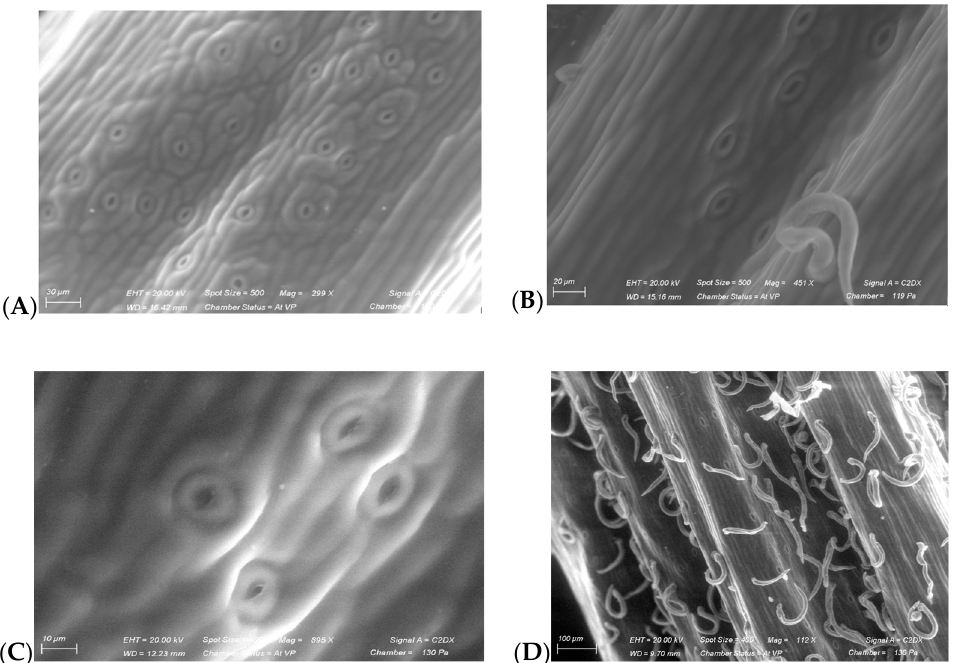
Figure 10. Ulex parviflorus stomata on young spine ( A ) and stem ( B ). Stomata and trichomes from mature spine ( C ) and stem ( D ). Scanning electronic microscopy (SEM).